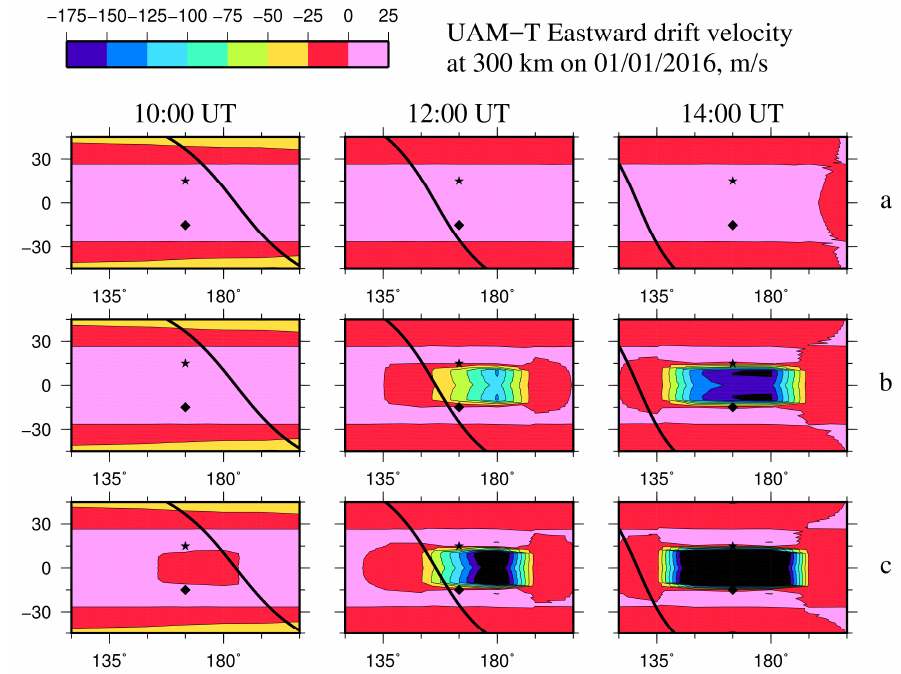
Figure 3. The UAM-T calculated eastward drift velocity (m/s) distributions at 300 km in geomagnetic coordinates at 10:00–14:00 UTC on January 1, 2016: ( a ) without seismogenic currents; ( b ) j s = 20 nA/m 2 ; ( c ) j s = 40 nA/m 2 .